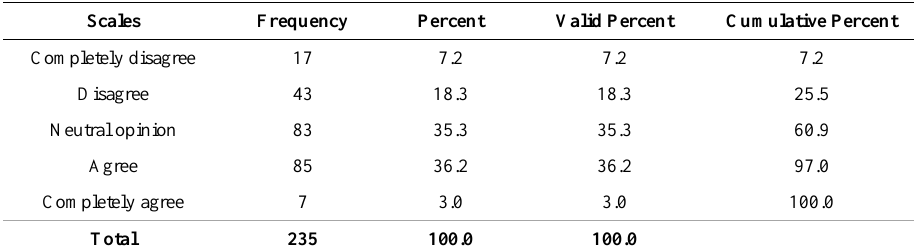
Table 5. Enterprises enhancing the creative capacity and marketing capacity